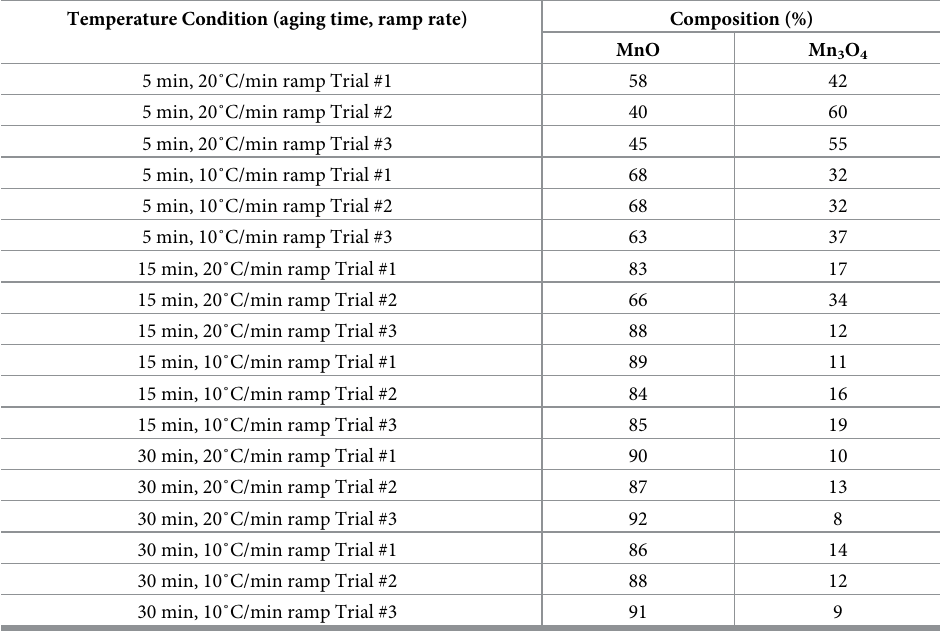
Table 1. MnO and Mn 3 O 4 composition (%) for NP trials based on X’Pert HighScore database. Temperature Condition (aging time, ramp